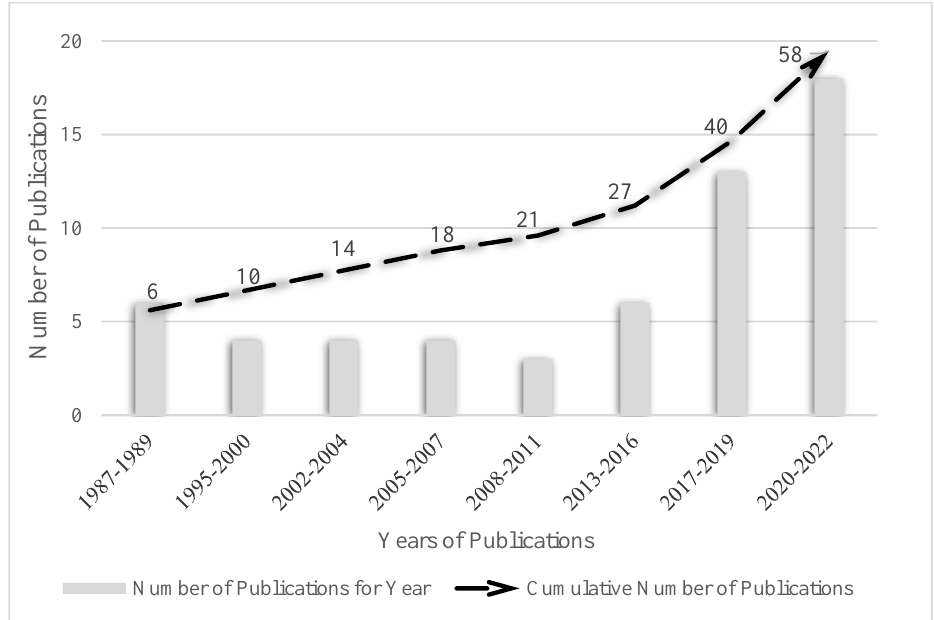
Figure 2. Number of articles every three years on the effects of air pollution on the health of older adults during physical activities.